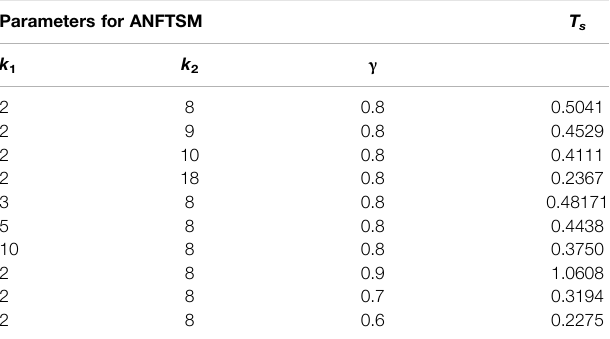
TABLE 2 | Upper bounds of settling-time for ANFTSM controller with various parameter values for Example 2. Parameters for